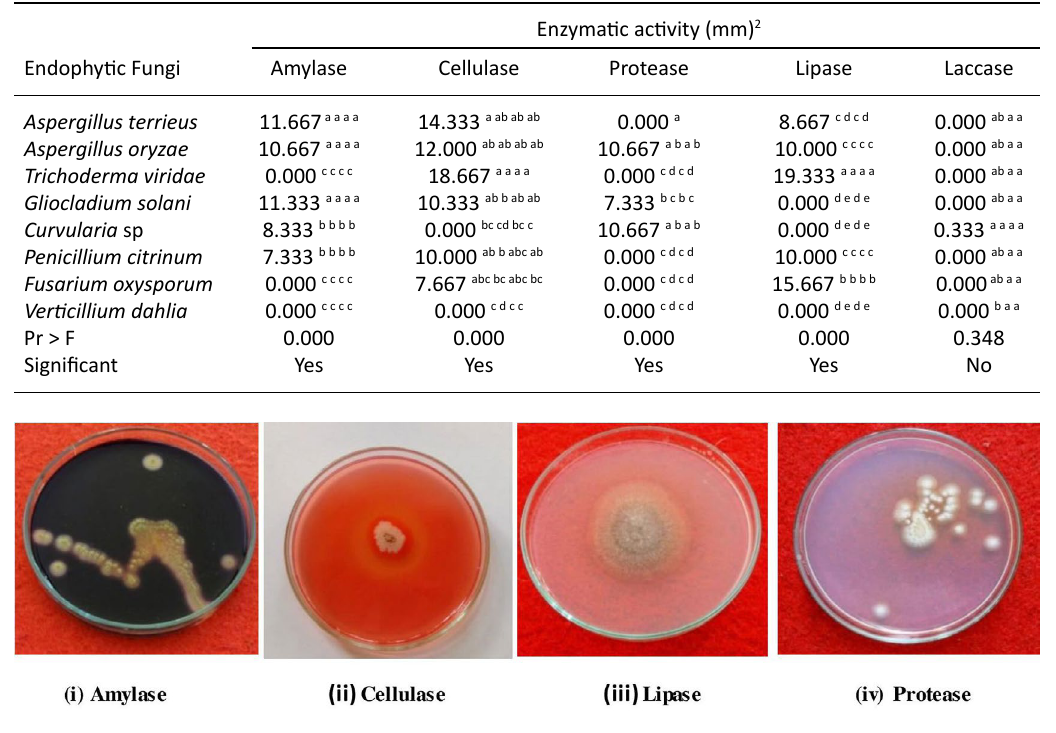
Table 3. Evaluation of the enzyme activity of endophytic fungi isolated from Litsea glutinosa